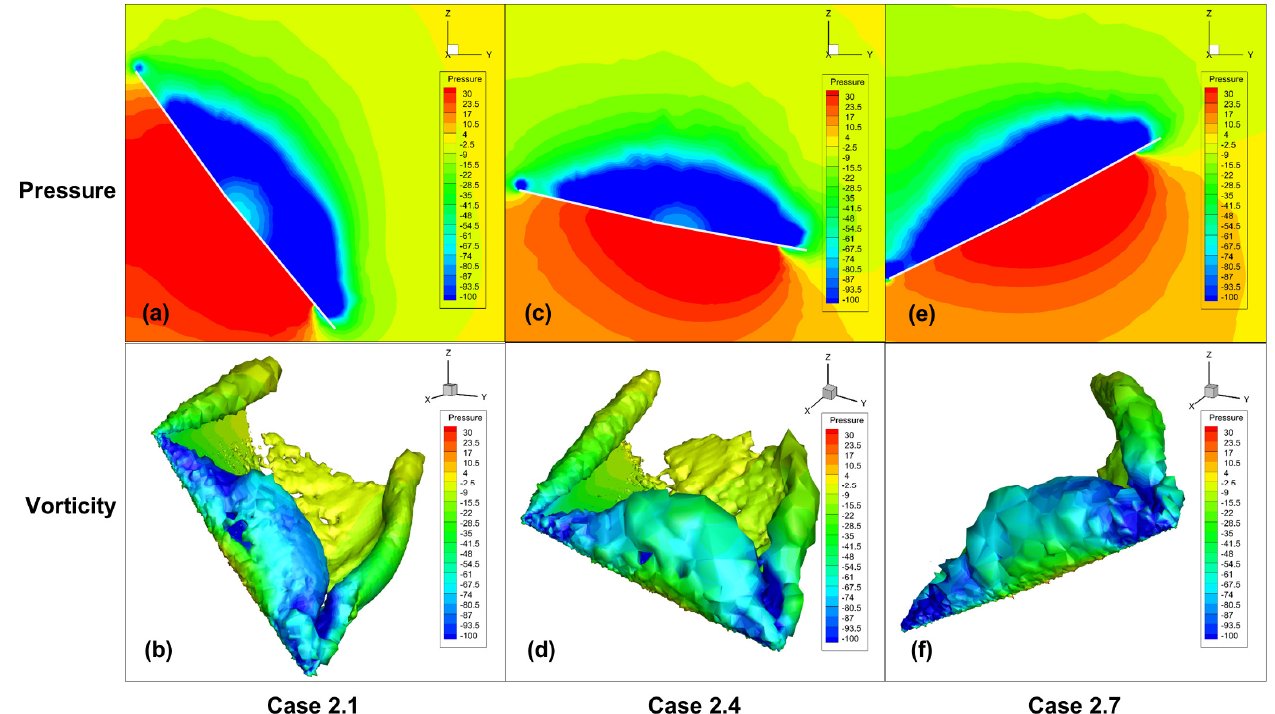
Figure 14. Pressure distribution and vorticity of typical cases at t* = 0.35: ( a ) pressure distribution of case 2.1; ( b ) vorticity of case 2.1; ( c ) pressure distribution of case 2.4; ( d ) vorticity of case 2.4; ( e ) pressure distribution of case 2.7; ( f ) vorticity of case 2.7.